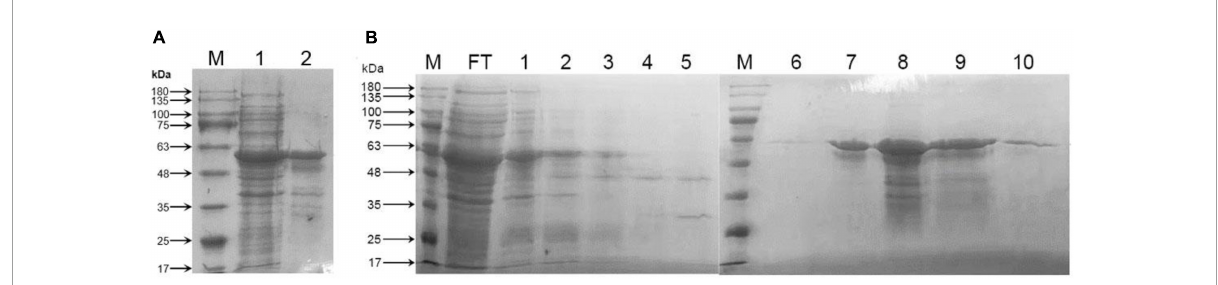
FIGURE4 Protein SDS-PAGE analysis. (A) SDS-PAGE analysis of total protein in E. coli carrying recombinant plasmid pET32a- crtE . M: protein marker; 1: soluble proteins in the supernatant; 2: inclusion body proteins in precipitation; (B) purification of CrtE from total soluble protein by HisTrap HP